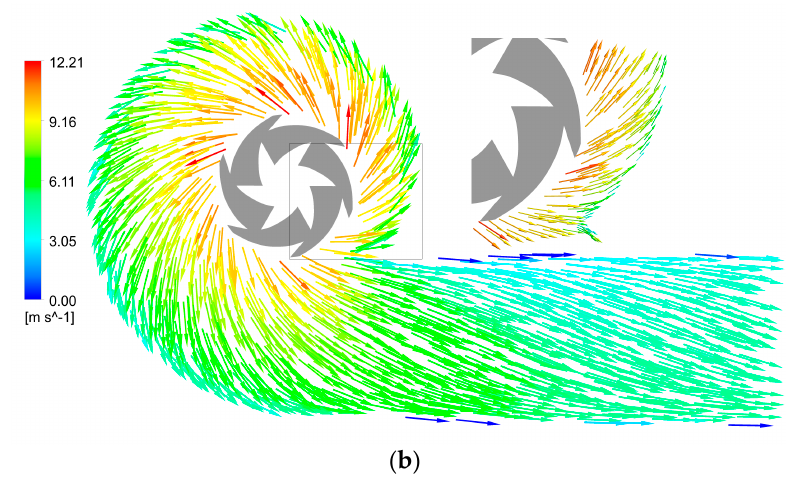
Figure 12. Velocity vector distribution at the point of 1.4 Q des with different phase positions: ( a ) 0°; ( b ) 30°.